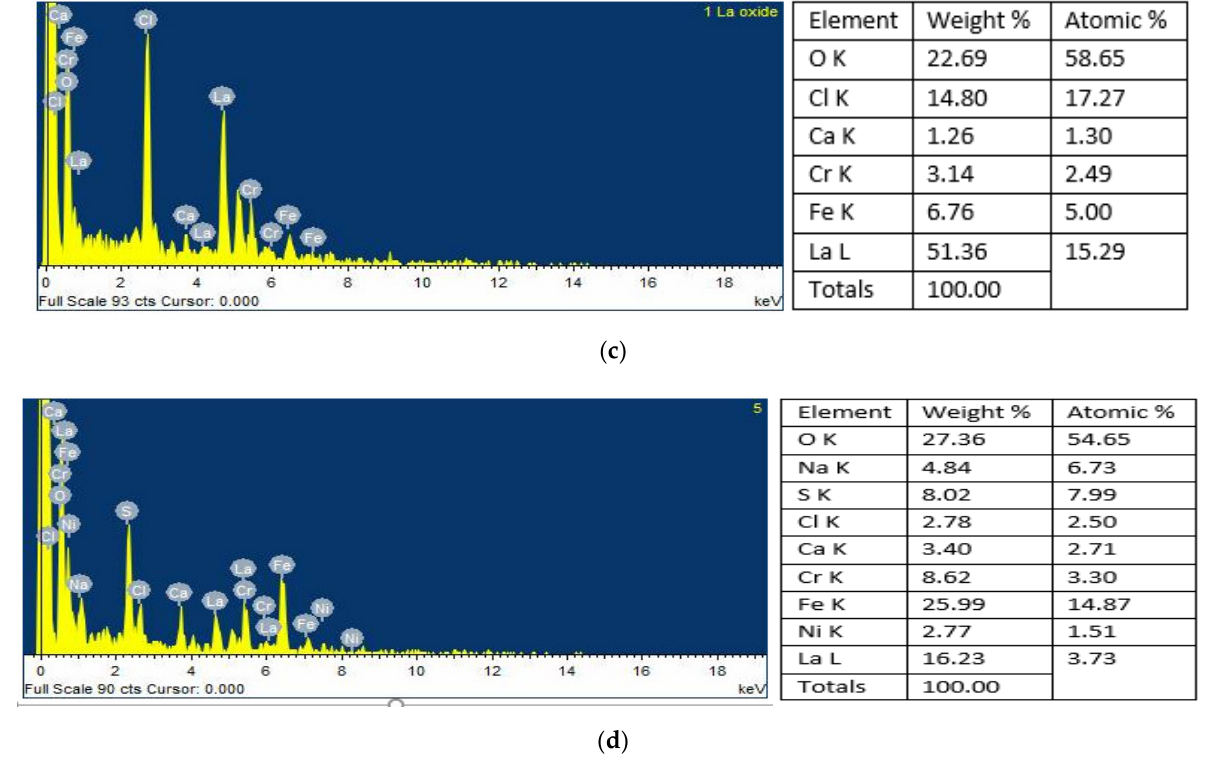
and and Ce(acac) (cid:5) 3